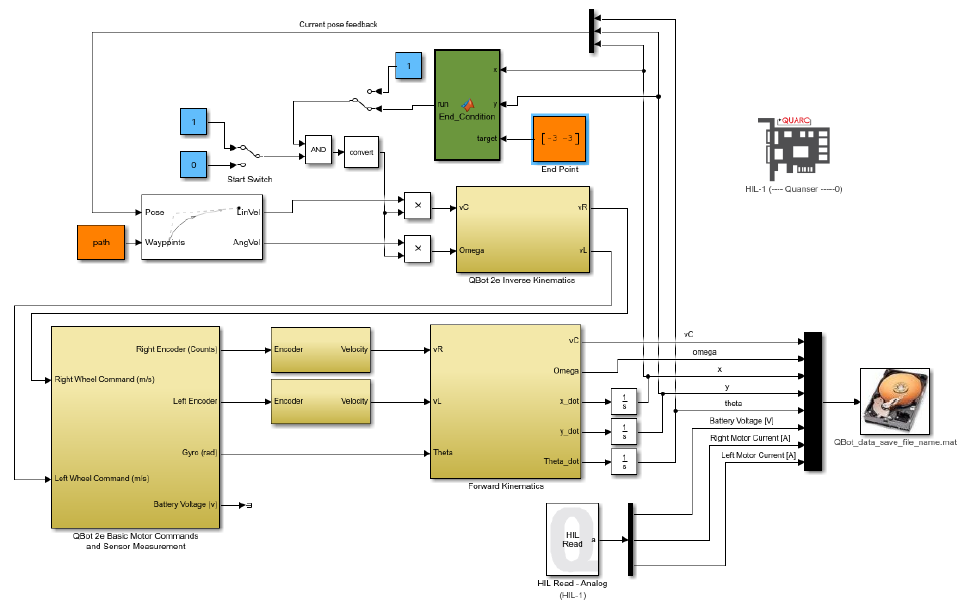
Figure 2. Simulink diagram used to control the QBot 2e robot with the pure pursuit